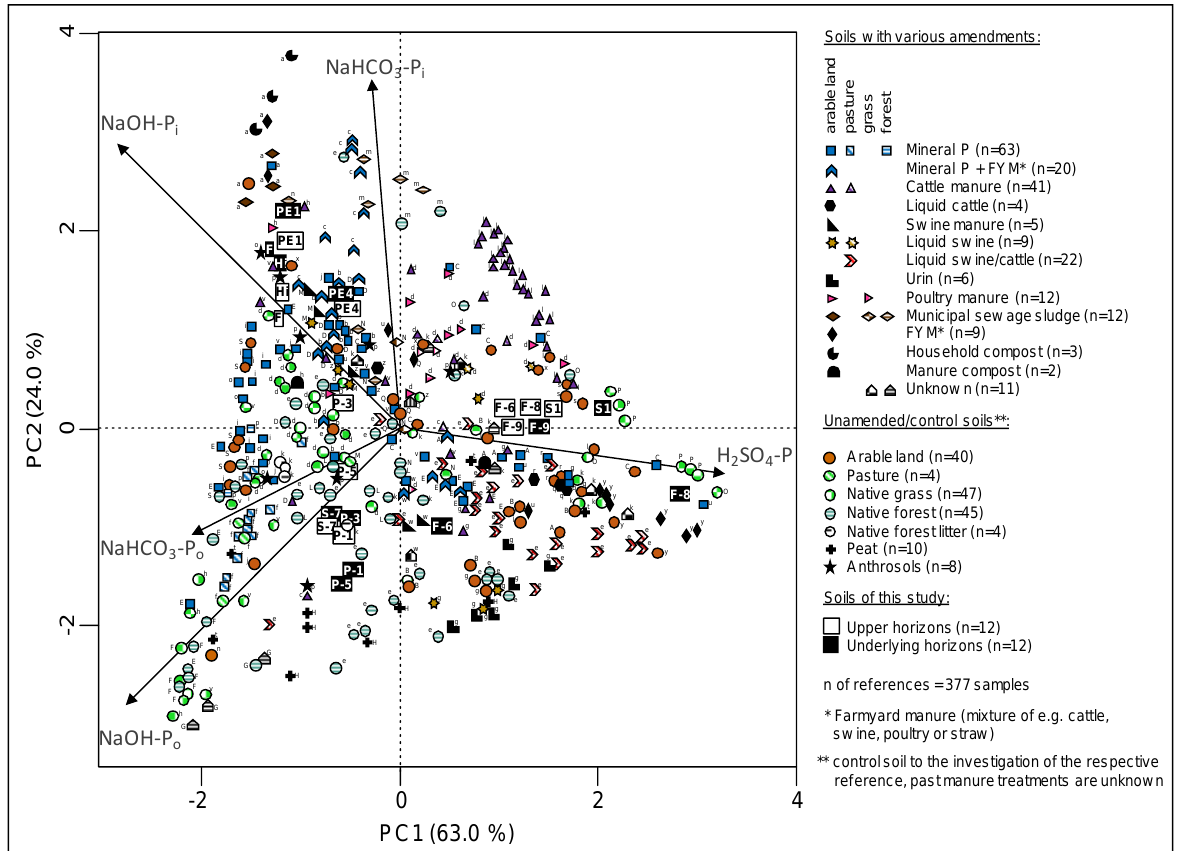
Figure 7. PCA score plot of the relative proportions of P-fractions as percent of the sum of fractions (NaHCO 3 -P i + NaHCO 3 -P o + NaOH-P i + NaOH-P o + H 2 SO 4 -P i ) in soils from the present study and reference soils. The PCA illustrates the separation of reference soils according to the type of manure applied and soil usage as well as the grouping of the Anthrosols under study with soils that received specific fertilizers. The values in the parenthesis show the proportions of the explained total variance of each compound. Letters next to the data symbols refer to reference: a [51], b [98], c [95], d [105], e [114], f [108], g [53], h [103], I [112], j [62], k [120], l [102], m